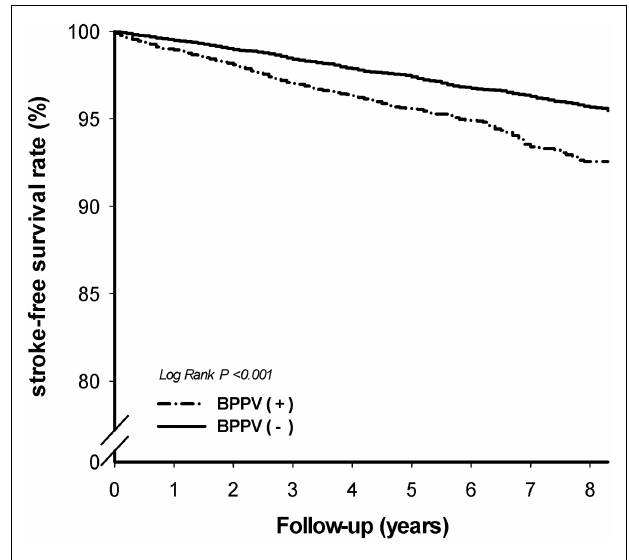
FIGURE 1 |The stroke-free survival curve was generated using Kaplan–Meier survival analysis